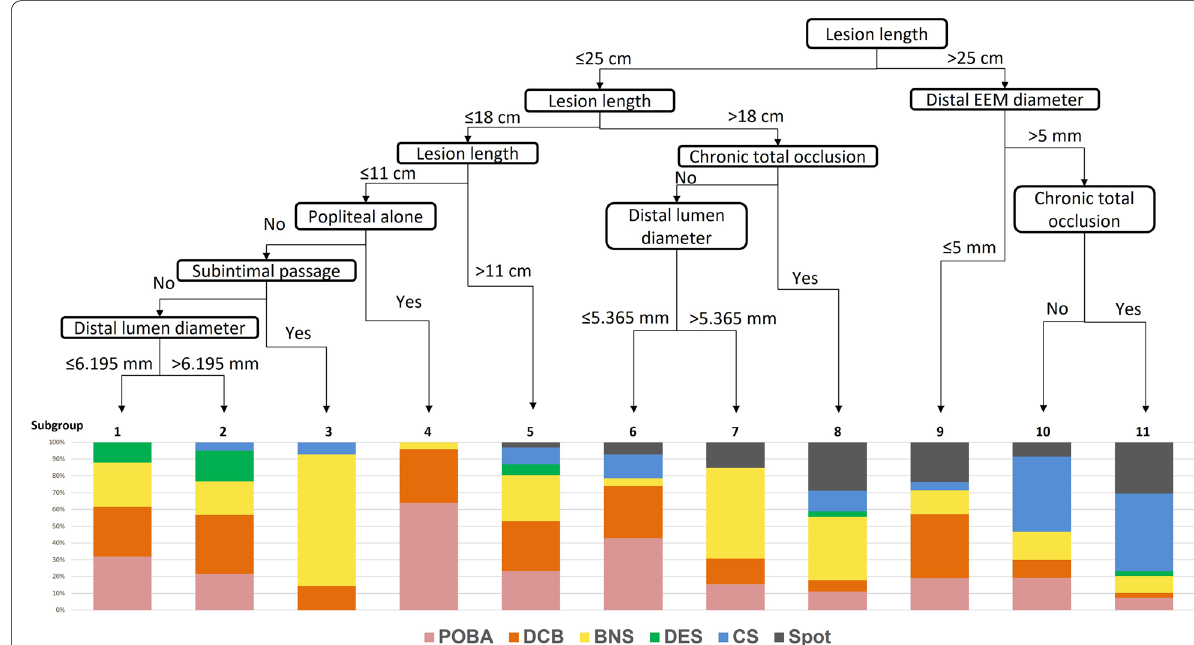
Fig. 3 Decision tree analysis. BNS: bare nitinol stent, CS: covered stent, DCB: drug-coated balloon, DES: drug-eluting stent, EEM: external elastic membrane, POBA: plain old balloon